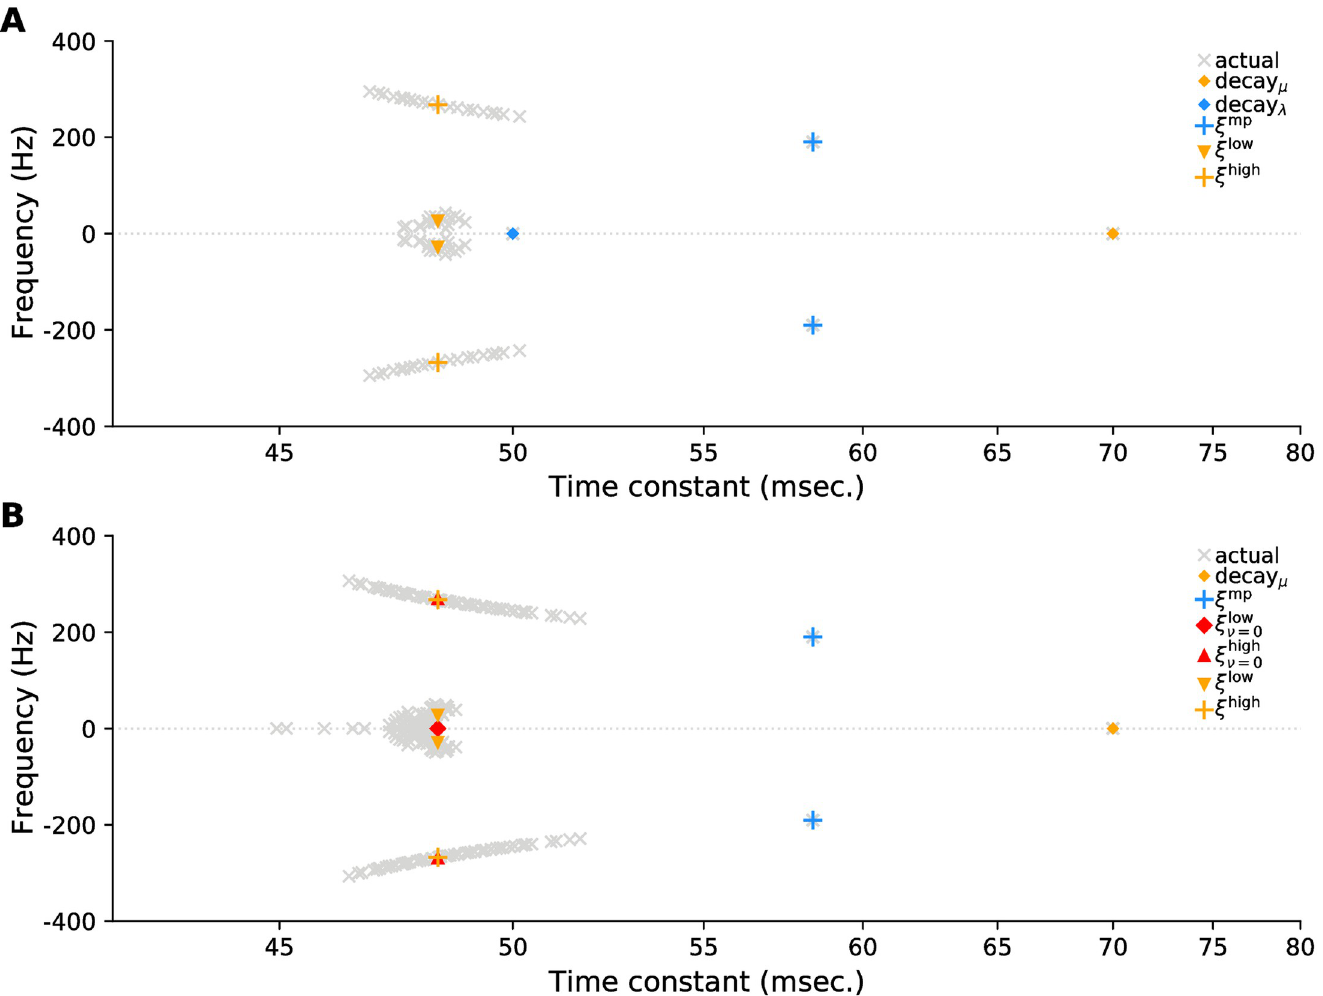
Fig 7. Eigenvalues of the linearized system computed numerically (gray crosses) and analytically (coloured symbols). Eigenvalues labeled ‘decay ‘decay λ ’, Eq (58) and ‘ ξ mp ’, Eq (59), are exact; those with the superscripts ‘low’ or ‘high’, Eq (76), are approximate. (A) n = 20 active granule cells. (B) n = 55, so that n > M . In both panels, blue eigenvalues are for modes involving only mitral and periglomerular cells, modes for orange and red eigenvalues also involve granule cells. The time constant ( x -axis) and frequency ( y -axis) for each eigenvalue ξ are − 1/Re( ξ ) and Im( ξ )/2 π ,respectively. We used large n to better show the spread of eigenvalues. Parameters from Table 1, except S = 25 and ε = 1/2, and n depends on the panel. See Sec. 4.2 for additional